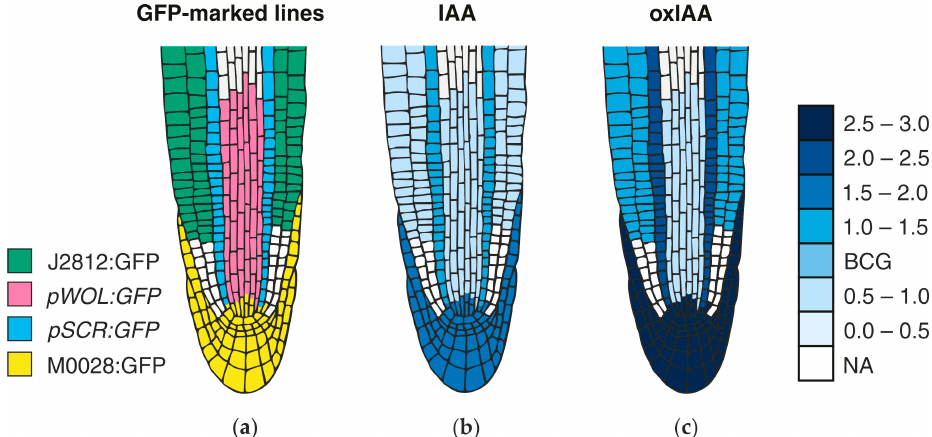
Figure 4. Auxin distribution map within the Arabidopsis root tip. ( a ) The data presented in the map was derived from four green fluorescent protein (GFP)-tagged Arabidopsis lines (J2812:GFP, pWOL:GFP , pSCR:GFP and M0028:GFP), covering almost all of the different cell types of the root apex. ( b , c ) Roots from eight-day-old Arabidopsis seedlings were protoplasted and sorted using FACS, and the concentrations of IAA ( b ) and oxIAA ( c ) were quantified in the separated GFP-expressing cell populations using LC-MS/MS. Cell type-specific concentrations of both auxins were calculated in fmol per 100,000 isolated GFP-expressing protoplasts and then normalised to the non-GFP-expressing reference population for each GFP cell line. “NA” represents cell populations that were not analysed; “BCG” means the background level. The maps were constructed based on the IAA and oxIAA levels published in [11].